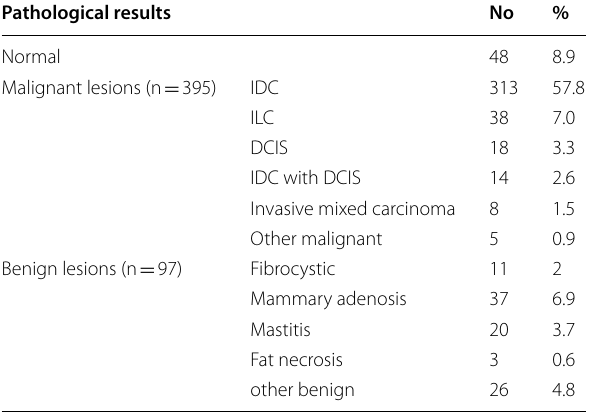
Table 6 Diagnostic indices of sonomammography and